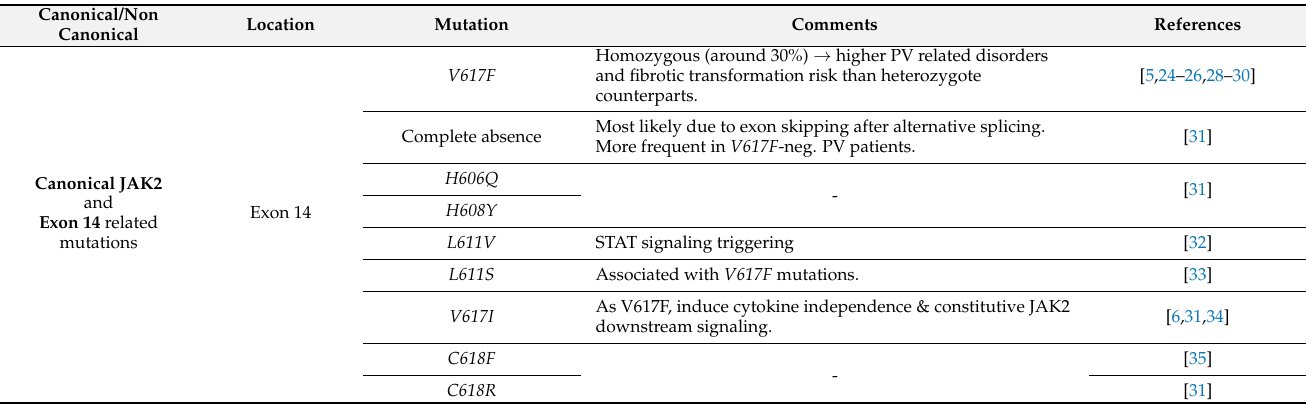
Table 1. Summary of canonical and atypical JAK2 mutations in PV. NB: 96% to 99% of patients that suffer from PV are JAK2